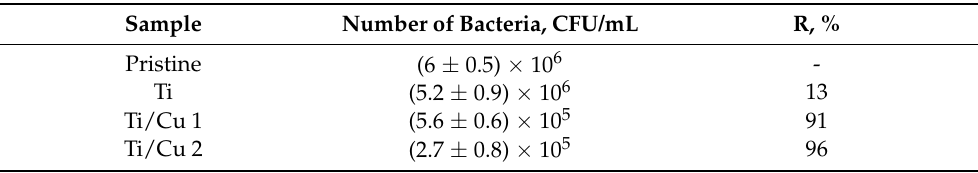
Table 5. Results of antibacterial activity